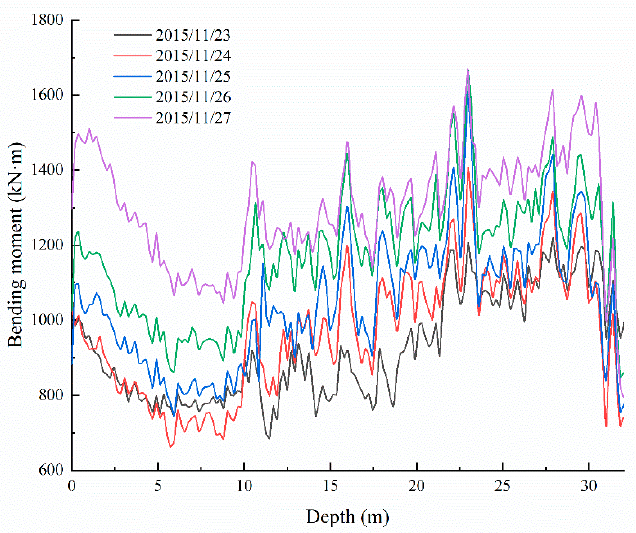
Figure 9. Early-stage graph of bending moment development of the anti-slide pile.